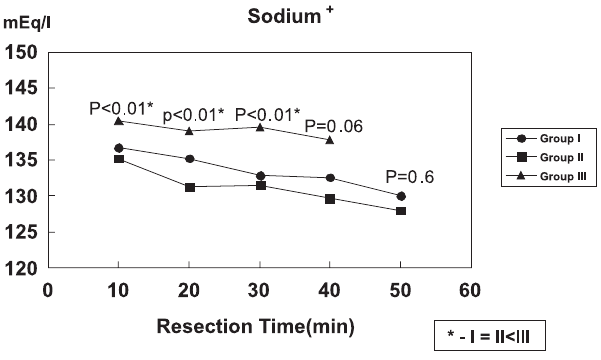
Figure 3 - Mean serum sodium levels during TURP in the three